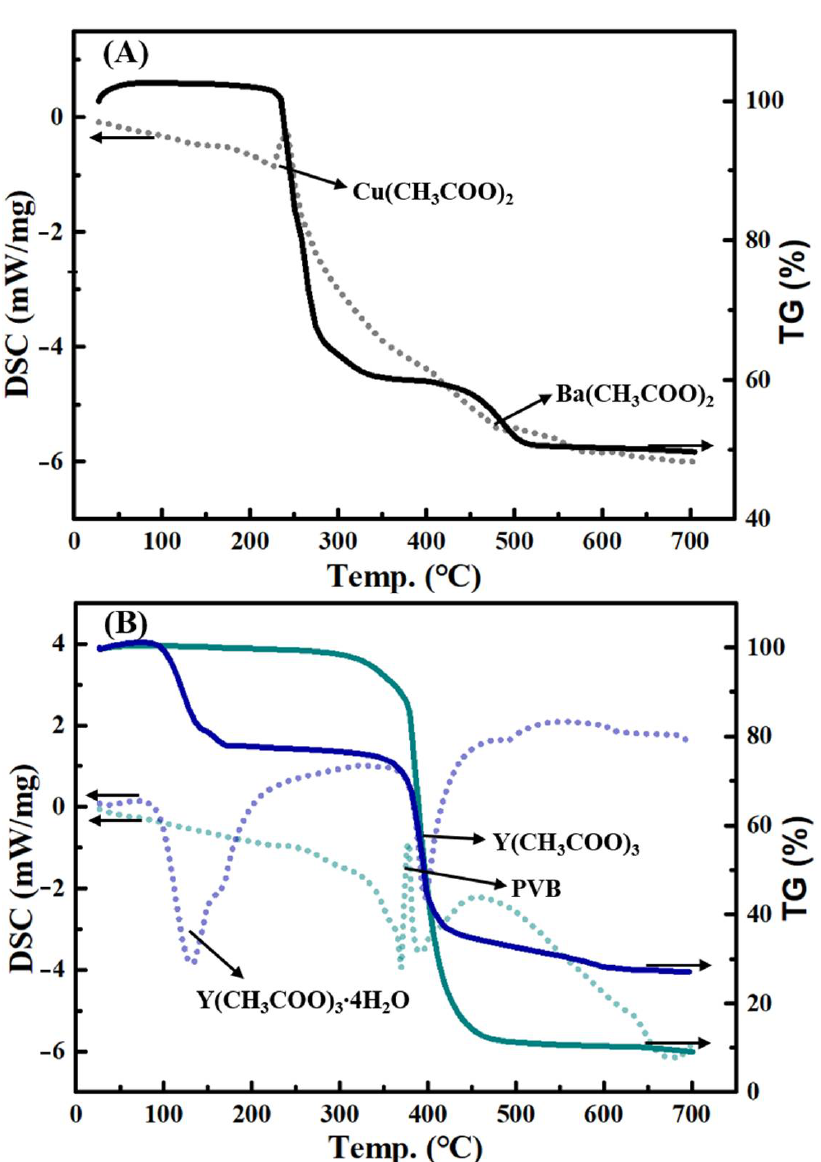
Figure 1. DTA/TGA of three acetates and PVB in argon gas at the heating rate of 20 ◦ C/min. ( A ) Mixture of Ba(CH 3 COO) 2 and Cu(CH 3 COO) 2 · H 2 O; ( B ) Y(CH 3 COO) 3 · 4H 2 O and PVB. The solid line is DSC, the dotted line is TG. The decomposition reactions of Cu (CH 3 COO) 2 (284 ◦ C), Y(CH 3 COO) 3 (398 ◦ C), Ba(CH 3 COO) 2 (460 ◦ C) and PVB (375 ◦ C) are shown in Equations (3)–(6), respectively (Figure